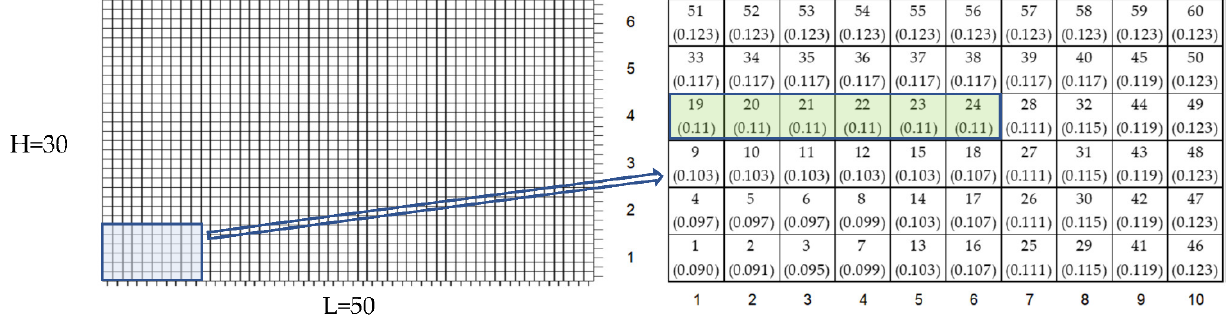
Figure 5. Cell numbers and